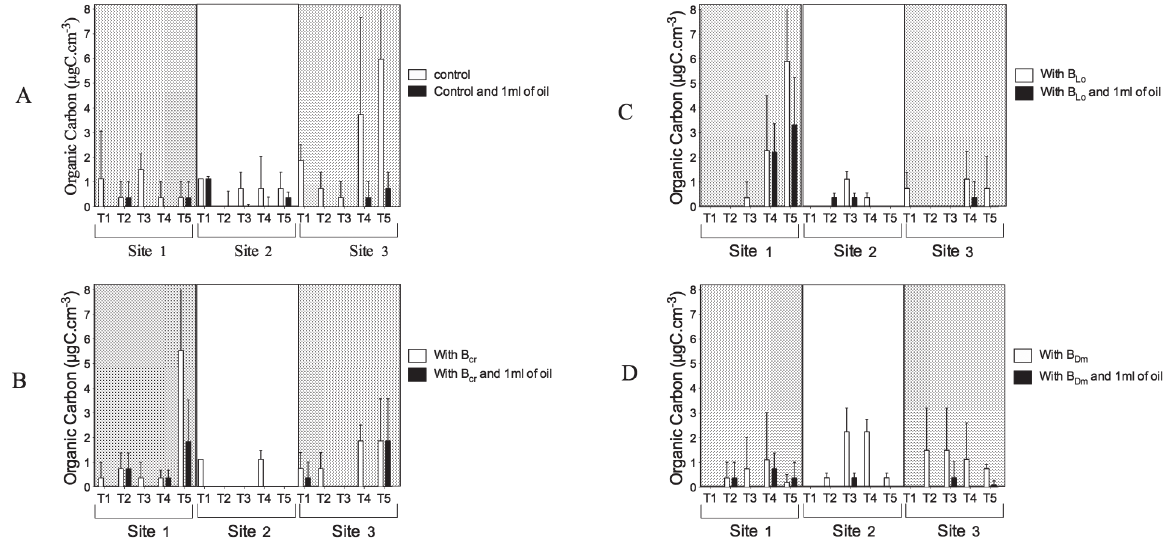
Figure 2 - Biomass from protists sampled from Guanabara Bay under influence of Bacterial consortia sampled from seaweed and oil. A-Control; B-With B